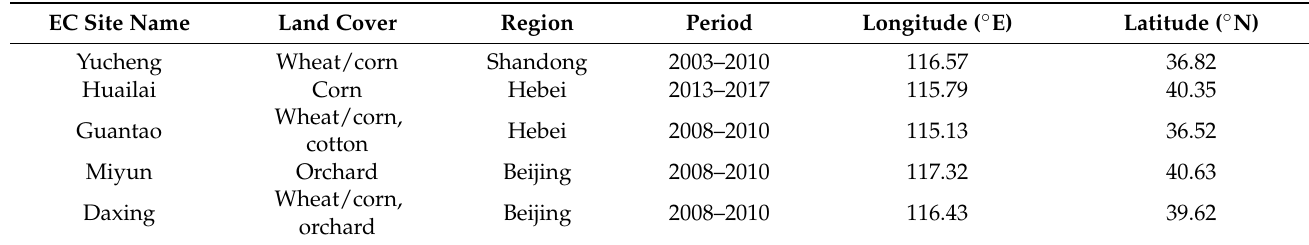
Table 2. Information about the flux towers used in this